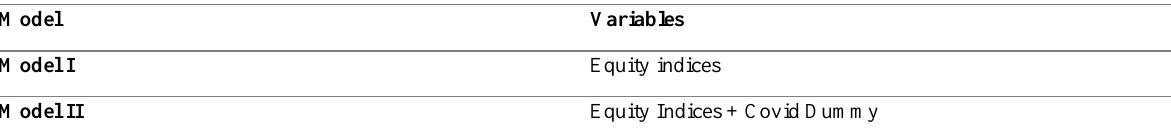
Table 1: Methodology